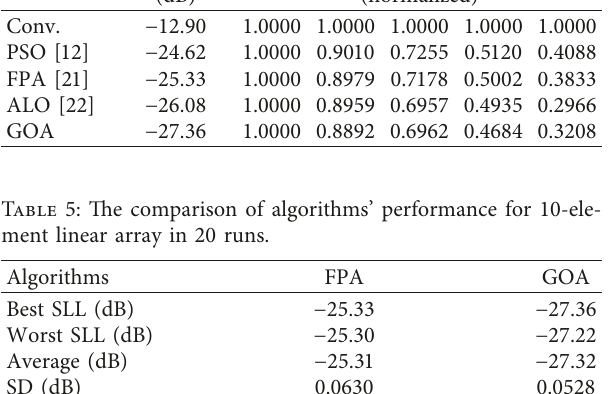
Figure 11: Distribution of maximum SLL for 20 runs of GOA for 16-element linear array in example